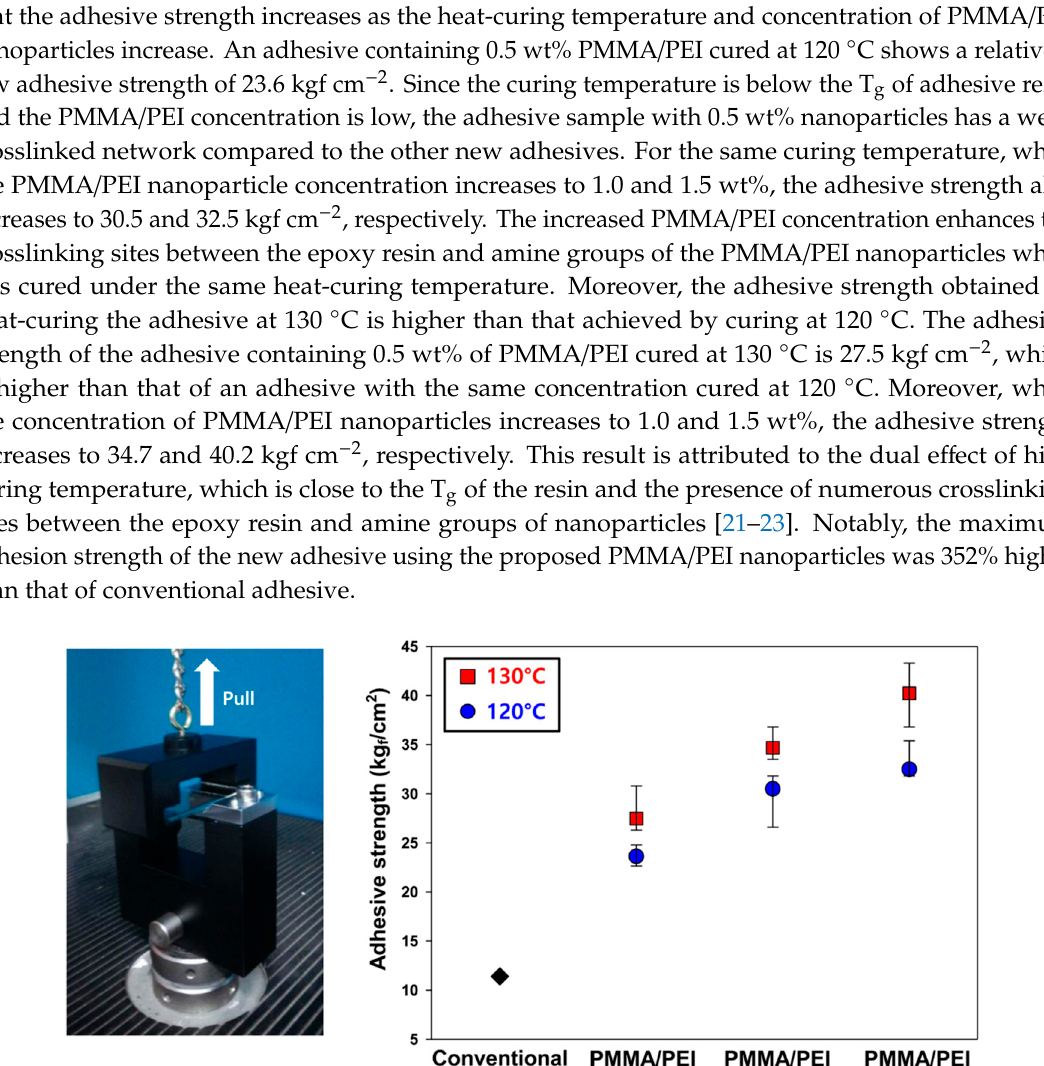
Figure 5. Adhesive strengths of conventional and new adhesives after heat treatment at 120 or 130 ° C.